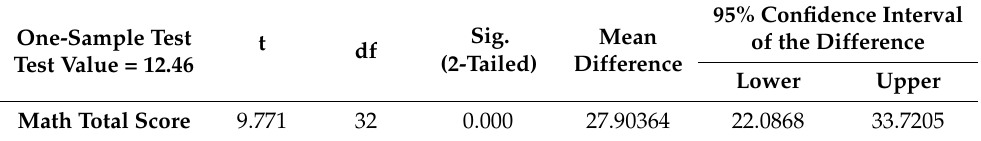
Table 4. T-Test for Math